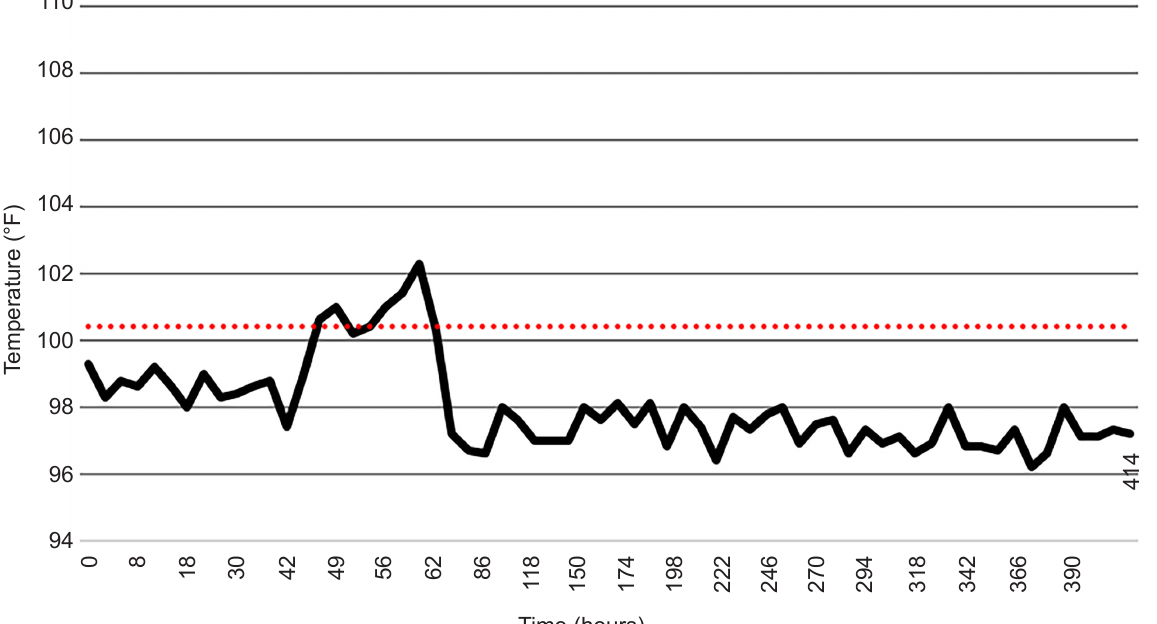
Figure 2. Patient two temperature vs. time.